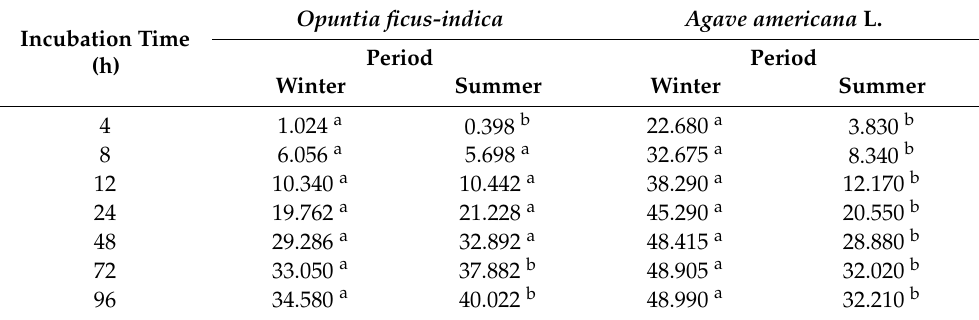
Table 4. Cumulative fitted values of gas production of the different plants in the two